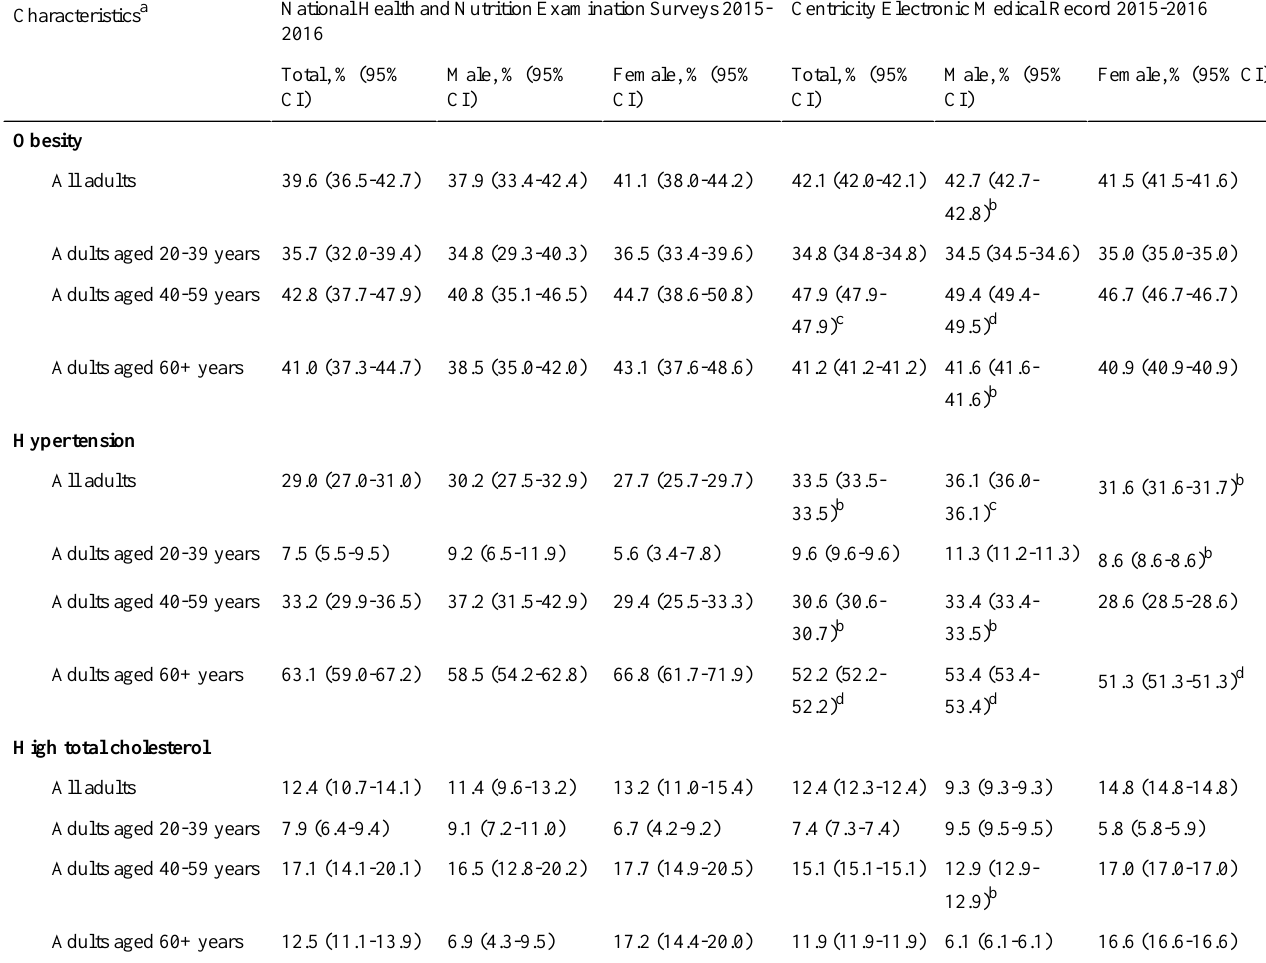
Table 2. Prevalence of chronic conditions in adult populations in the National Health and Nutrition Examination Surveys and the Centricity Electronic Medical Record.